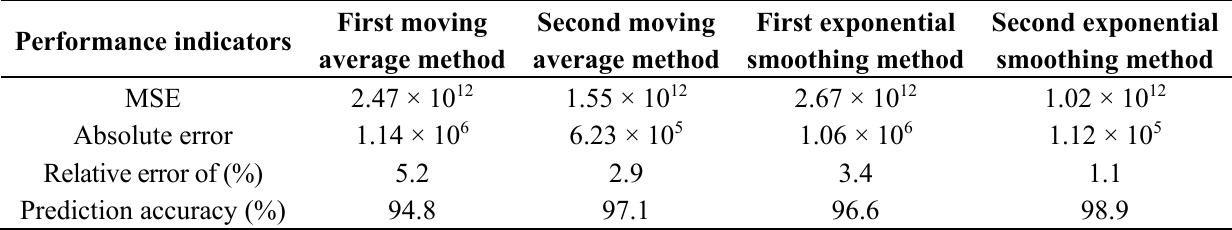
Table 1. Performance comparison